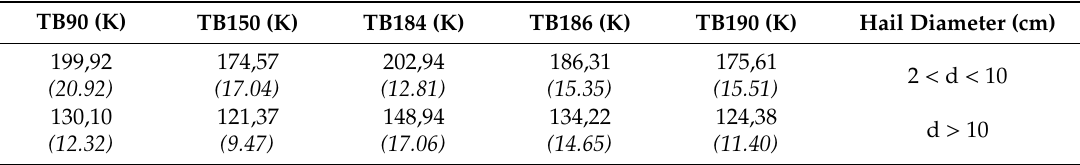
Table 2. Averaged minimum brightness temperature (TB) thresholds at the channel frequencies calculated for the two hail diameter classes. Italics indicate the standard